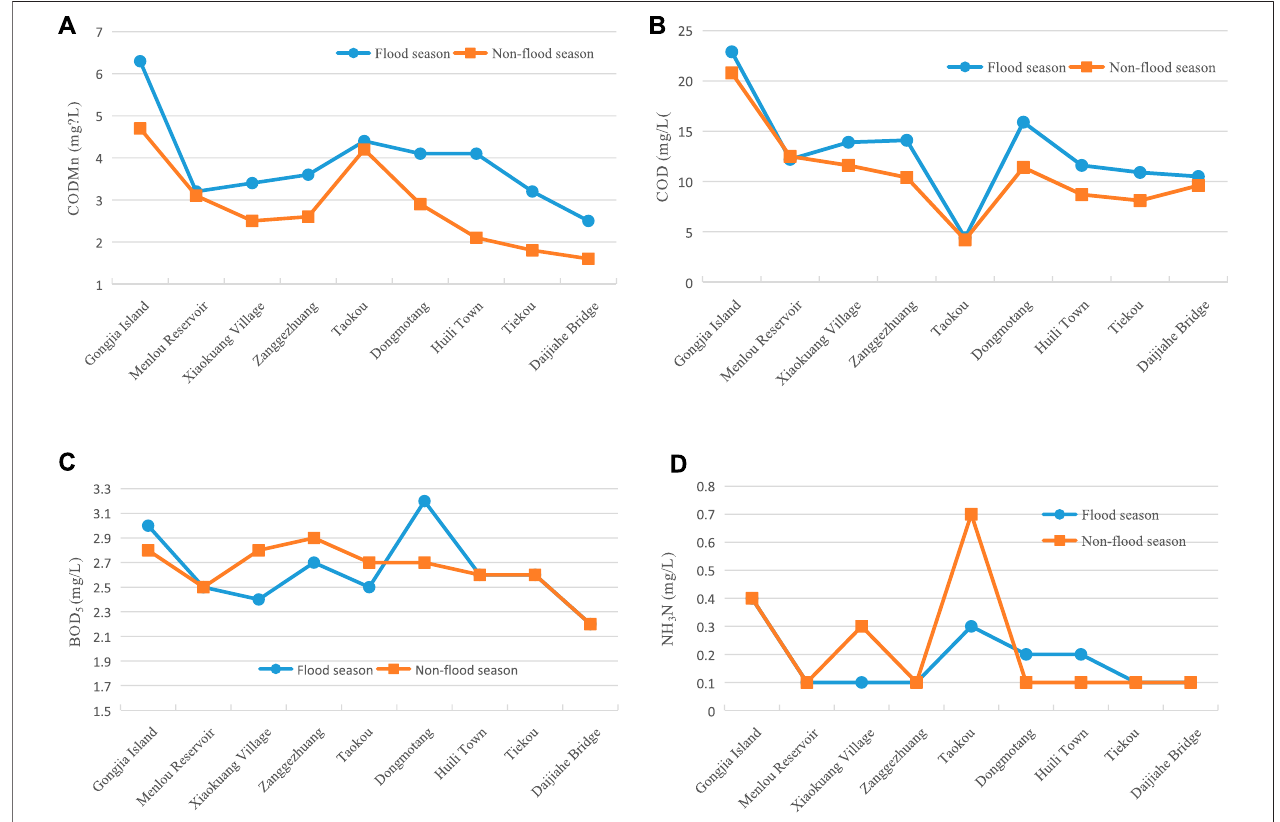
FIGURE 6 | Monthly organic oxygen consumption pollutants (OCP) in the Dangujia River in the fl ood and non- fl ood seasons in the 2008 assessment year: (A) CODMn concentrations, (B) COD concentrations, (C) BOD5 concentration, and (D) NH3N concentration.